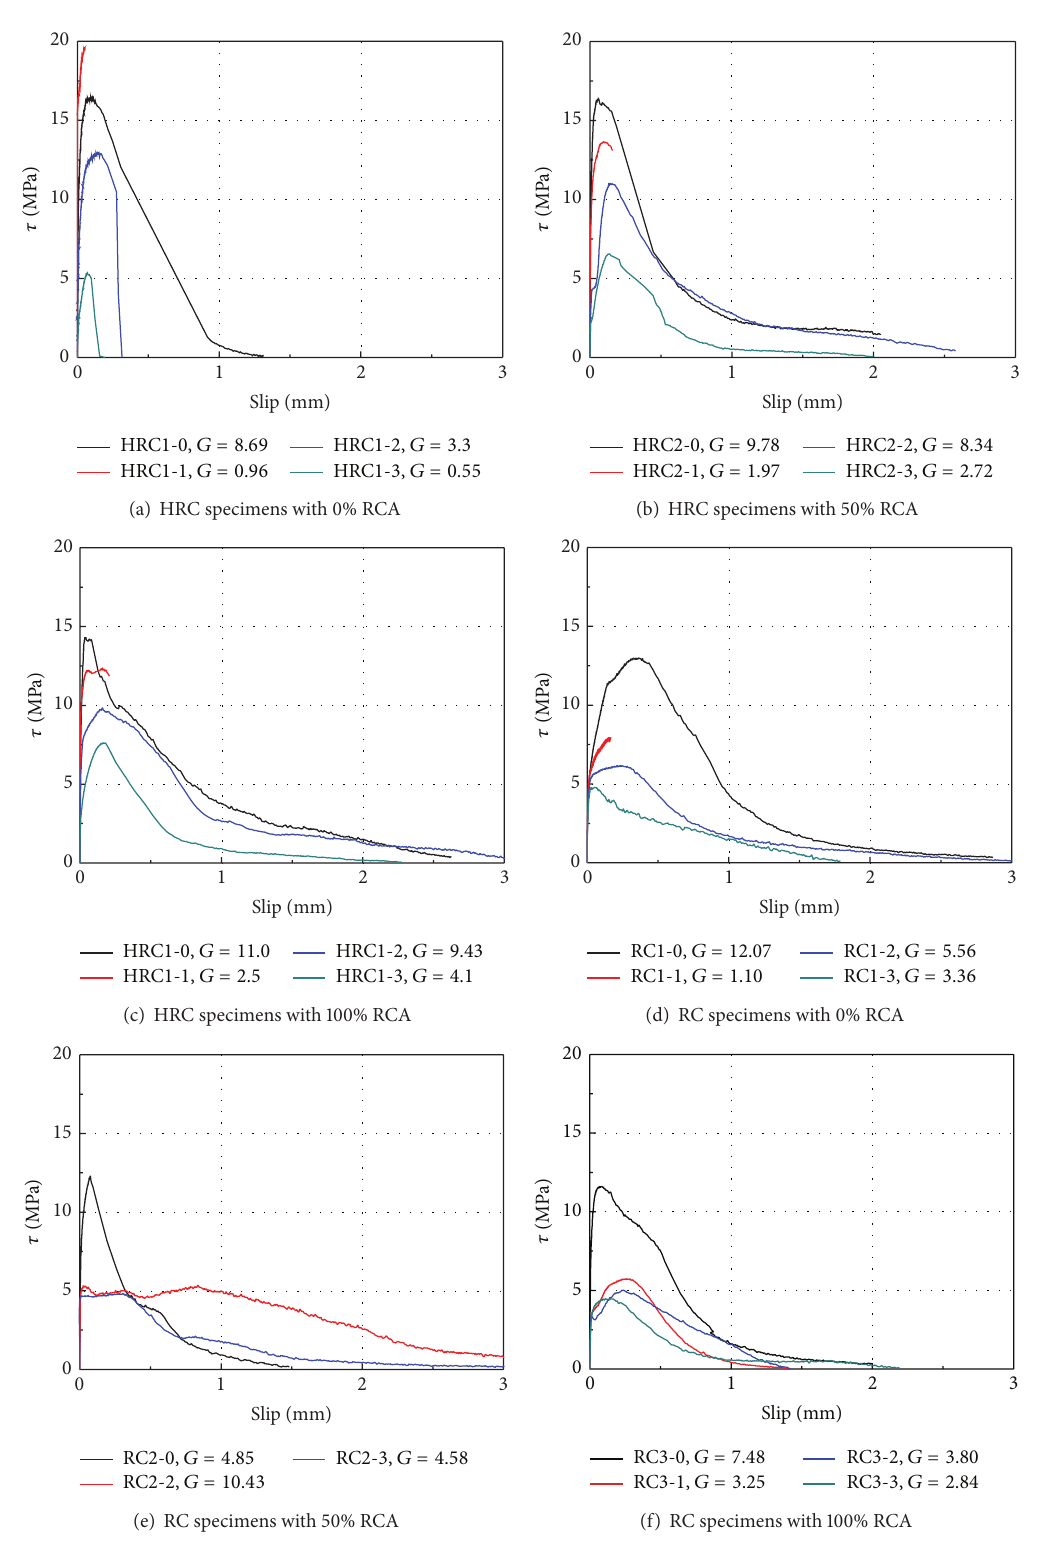
Figure 4: Bond-slip curves of different